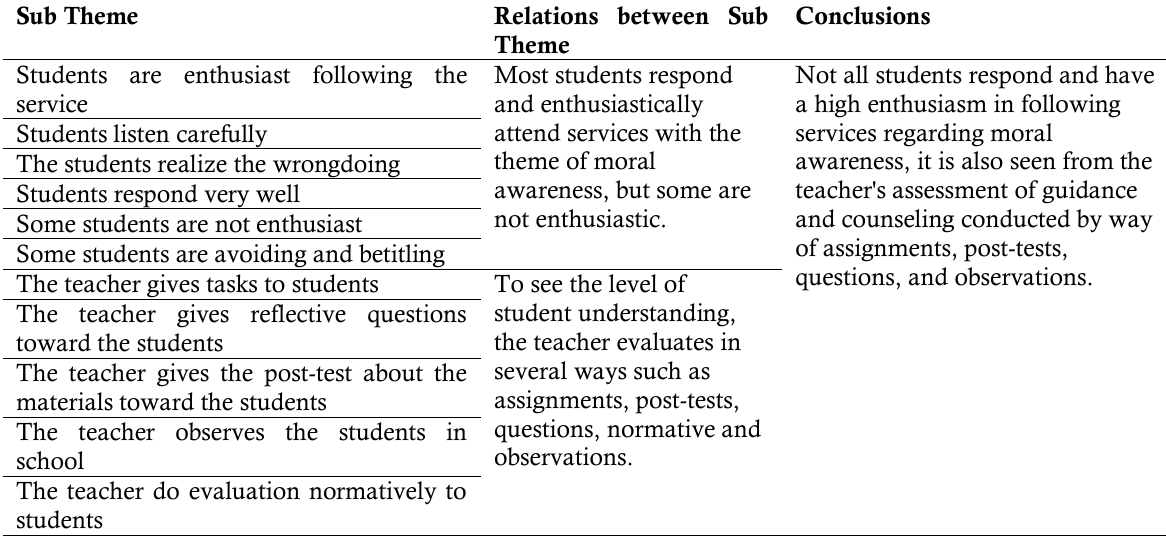
Table 4 . Student Responses when Given Moral Awareness